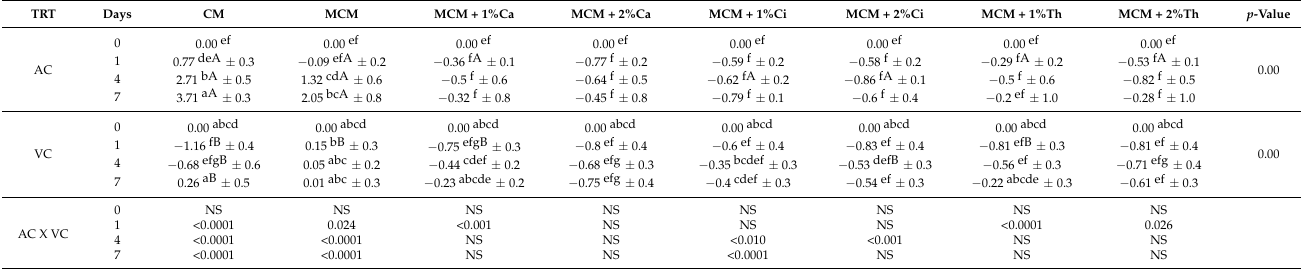
Table 2. Population changes of mesophilic total plate count (log (N0/N) ± SD CFU/g) in marinated camel meat with essential oils under aerobic (AC) and vacuum (VC) conditions after storage at 10 ◦ C for 0, 1, 4 and 7